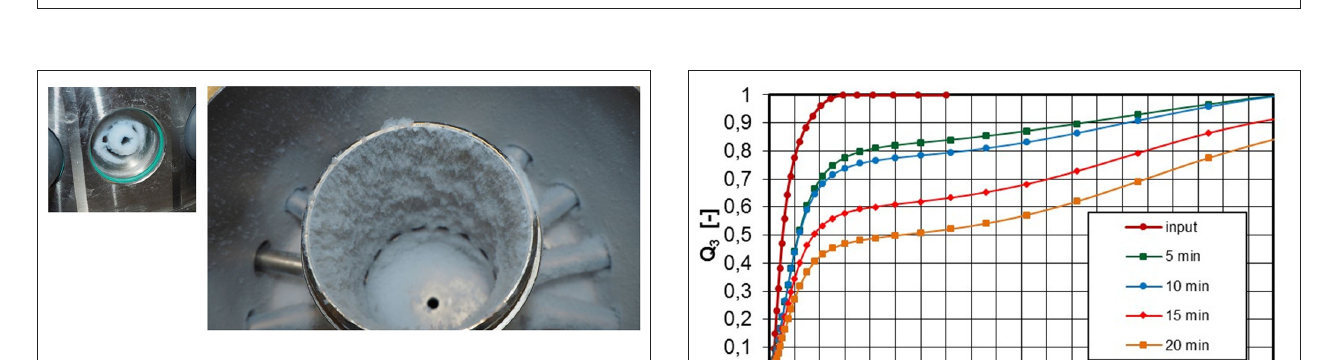
FIGURE 5 | Untreated pyrogenic silica, particle deposits in the inhalation chamber after an operating time of 120min with c m = 4,700 mg/m 3 , left: exposure port, right: inner cylinder and chamber.